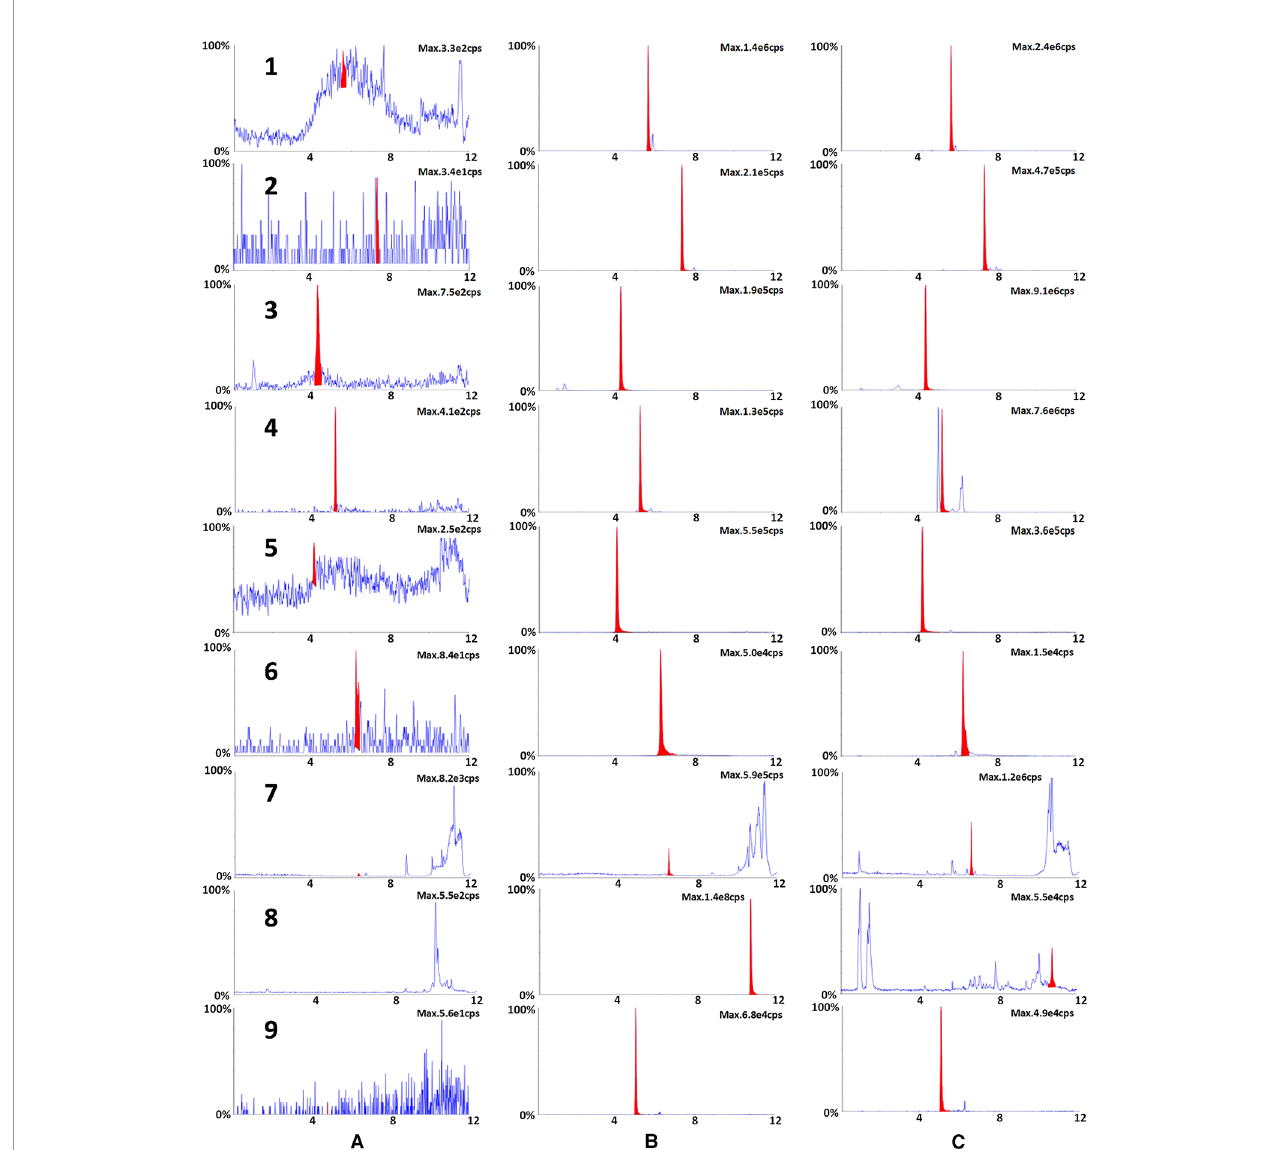
FIGURE 1 | The typical chromatograms of blank (A) , a standard mixture of nine markers (B) and XBJ sample (C) . Nine representative bioactive ingredients were identi fi ed in XBJ using UPLC-MS/MS analysis: 1. ferulic acid, 2. benzoylpaeoni fl orin, 3. HSYA, 4. PAE, 5. protocatechuic aldehyde, 6. salvianolic acid B, 7. senkyunolide I, 8. tanshinone IIA, 9. alibi fl